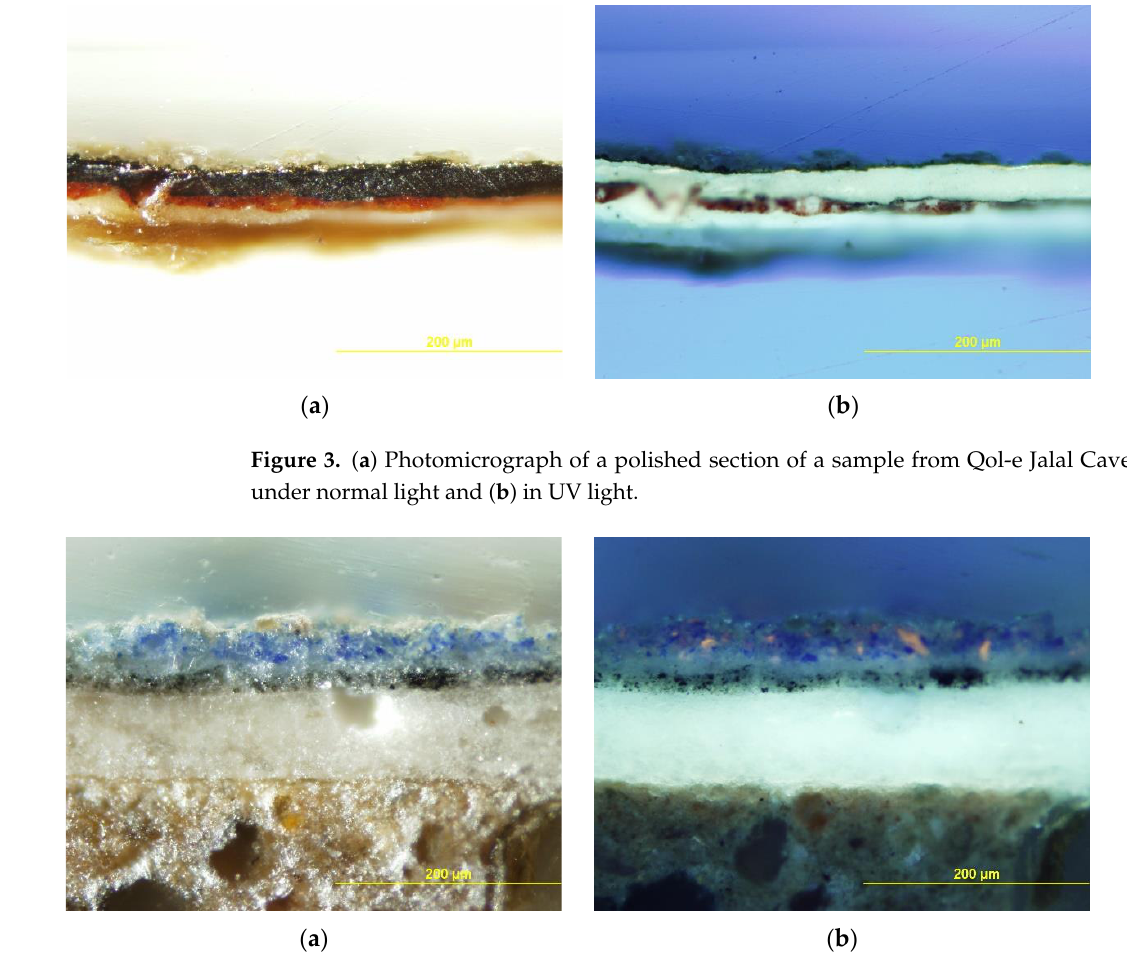
Figure 4. ( a ) Photomicrograph of a polished section of a sample from Cave K 3 , Bamiyan (BMM135) under normal light and ( b ) in UV light.